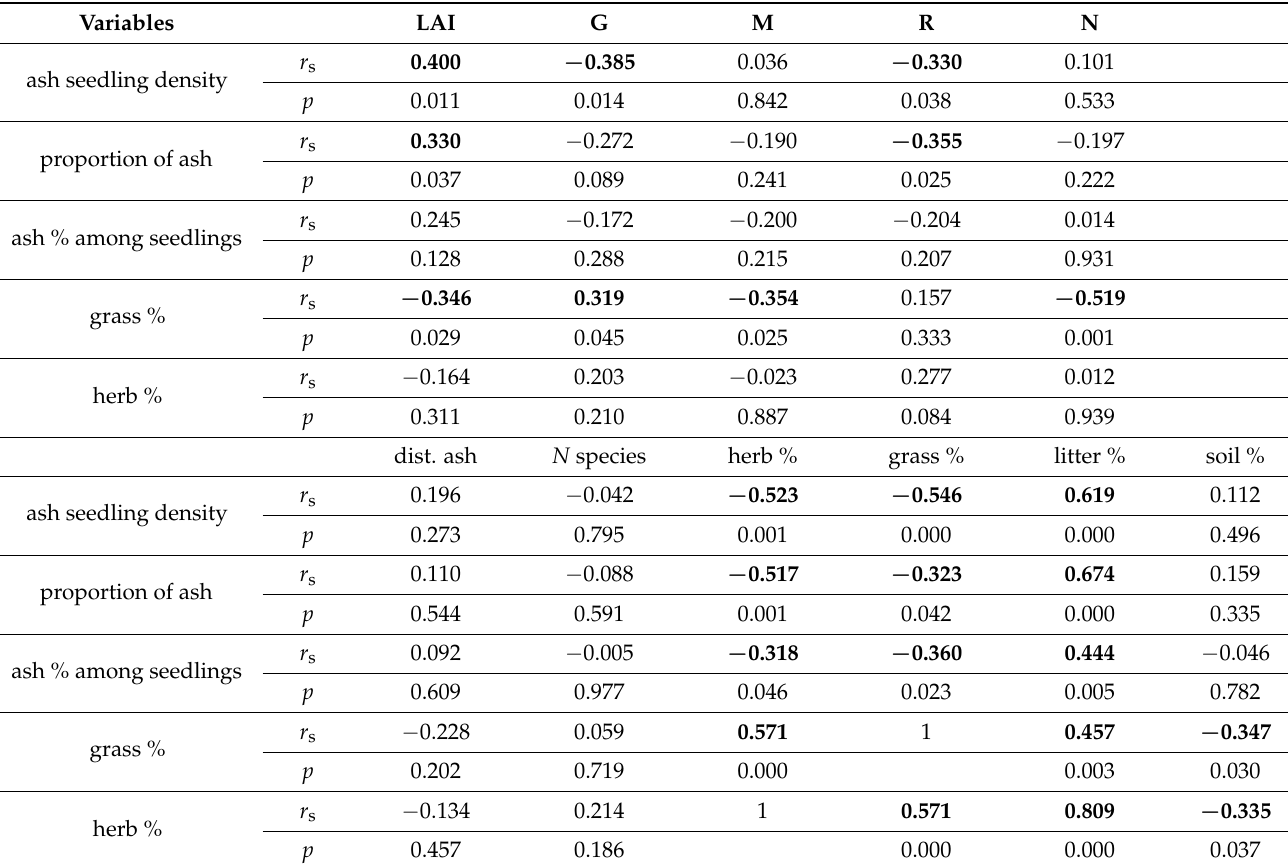
Table 3. Summary on Spearman’s rank correlation coefficients ( r s ) and p -values of all surveyed abiotic and biotic variables related to ash-regeneration metrics and coverage of grass and herb layer. LAI: Leaf Area Index, G: gap fraction, M, R, N: Ellenberg indicator values for soil moisture, reaction, and nutrients, dist. ash: distance to the next adult ash tree. Bold values indicate significant correlations ( p <